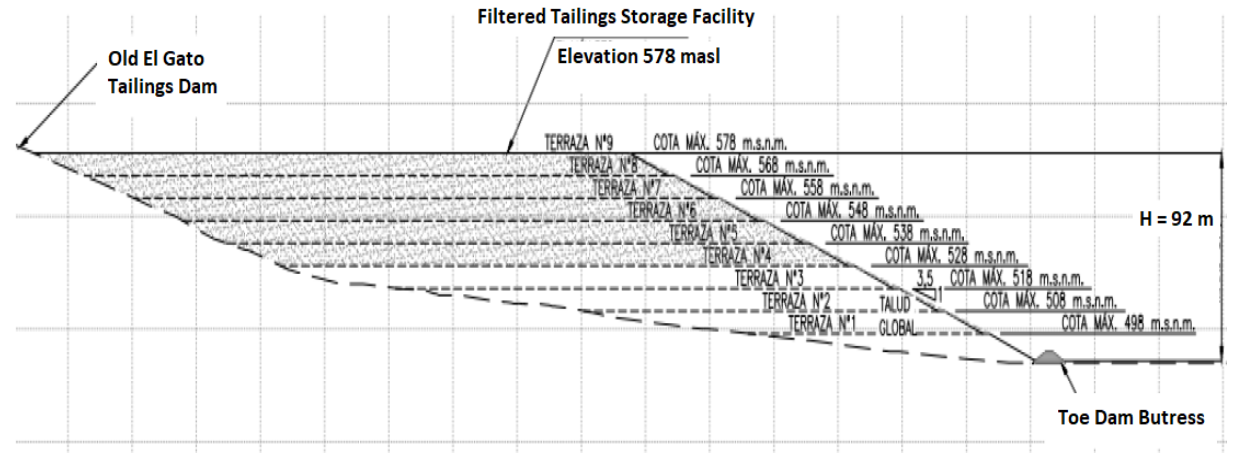
Figure 27. El Gato Creek Filtered Tailings Storage Facility–Typical Cross Section [27,47,61].